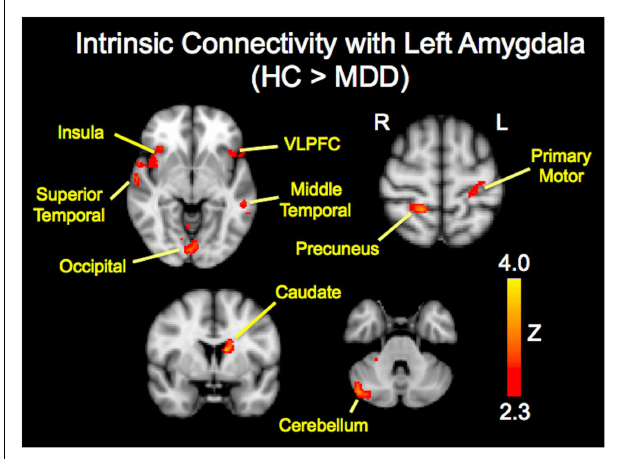
FIGURE 1 | Brain regions showing reduced resting-state functional connectivity with the left amygdala in depressed patients compared with healthy controls . Colored areas indicate significant Z -scores as determined by fMRI. Statistical threshold of Z = 2.3 ( p = 0.01).